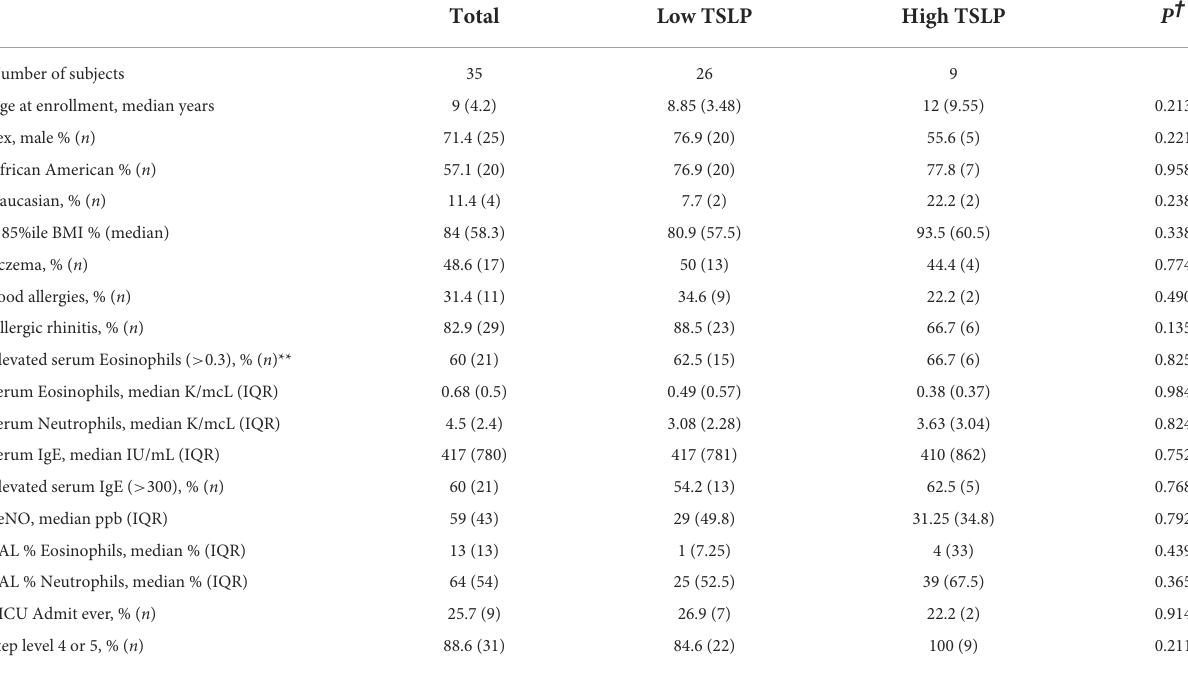
TABLE 2 Clinical features according to high airway TSLP status in